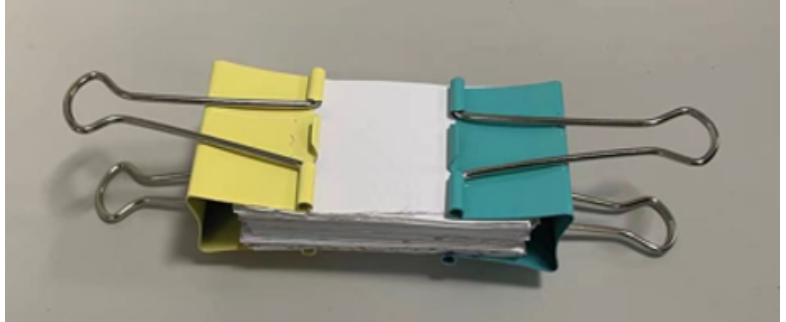
Figure 2. Paper stack held in custom-build jig based on binder clips (Home Depot, medium, multi- color). Size of paper sheets is ∼ 8 cm × 5 cm.